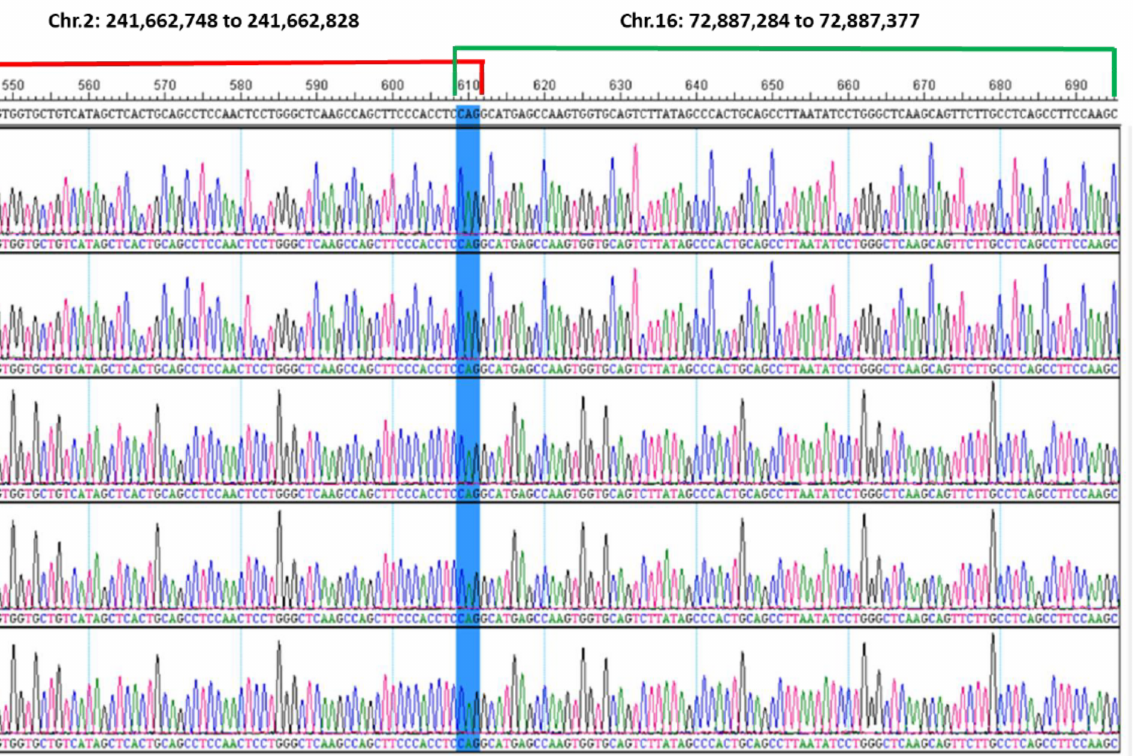
Figure 4. DNA Sanger sequencing result. Five selected clones submitted for Sanger sequencing were aligned here using the DNASTAR Lasergene 17 SeqManPro. They showed completely consensus sequences. The 71 bases on the left side (541 to 611 bp) were blasted to the region of 241,662,758 to 241,662,828 of chromosome 2, while the 92 bases on the right side (609 to 700 bp) were blasted to the region of 72,887,284 to 72,887,377 of chromosome 16. Both sides are with 100% of identities. The three bases of CAG (609 to 611) highlighted in blue were a microhomology shared by both chromosomes 2 and 16 in this